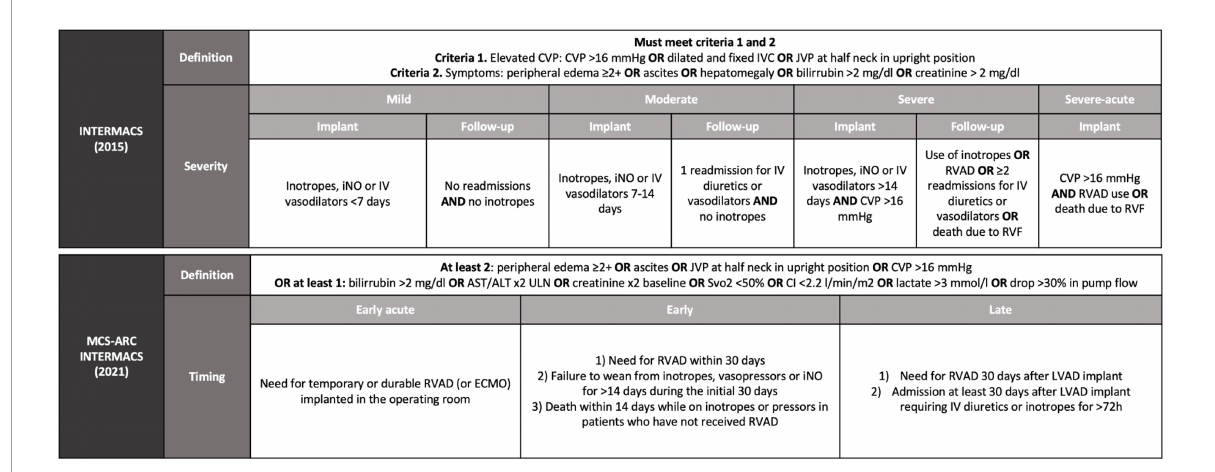
FIGURE1 Definition of right ventricular failure after LVAD implantation according to INTERMACS from 2015 and from 2021. INTERMACS, interagency registry for mechanically assisted circulatory support; MCS-ARC, mechanical circulatory support–academic research consortium; CVP, central venous pressure; IVC, inferior vena cava; JVP, jugular venous pressure; iNO, nitric oxide; IV, intravenous; RVAD, right ventricular assist device; RVF, right ventricular failure; ULN, upper limit of normal; Svo2, central venous oxygen saturation; CI, cardiac index; ECMO, extracorporeal membrane oxygenator; LVAD, left ventricular assist